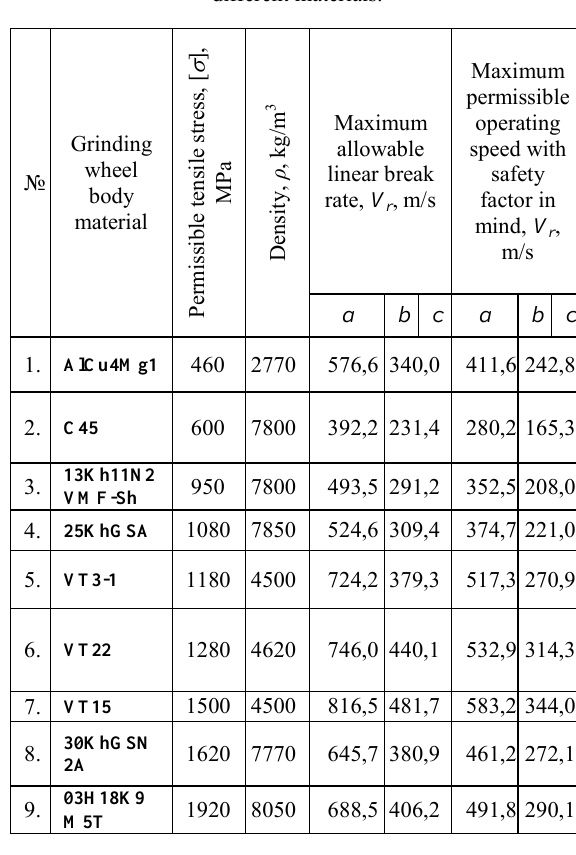
Table 2. Grinding wheel body calculation results from different materials.